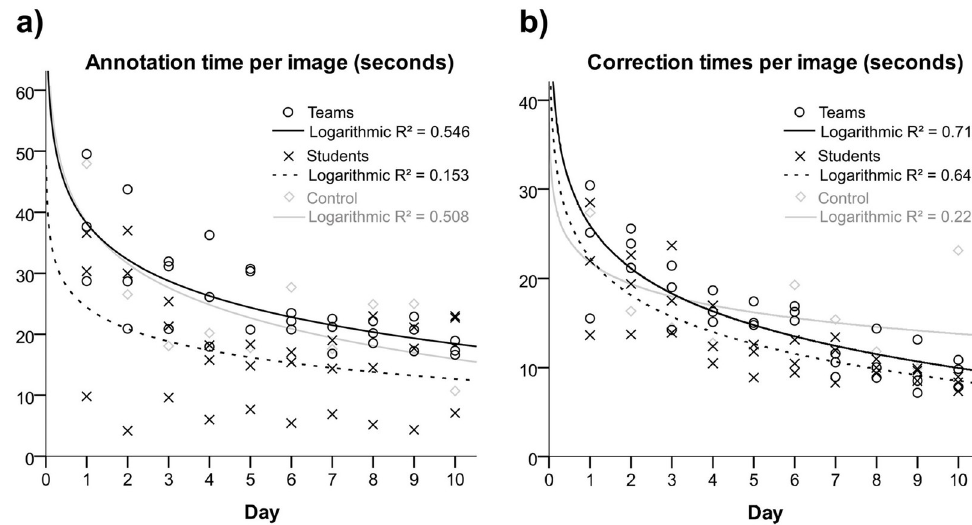
Fig 3. Regression analyses of annotation (a) and correction times (b). Logarithmic curve fittings are given for all three rater groups. 17.4 ± 9.5 seconds in individual raters, and 24.6 ± 9.9 seconds in control. Correction time was 16.8 ± 5.1 per image on average; 14.8 ± 5.6 seconds for teams, 15.5 ± 5.7 seconds for individual